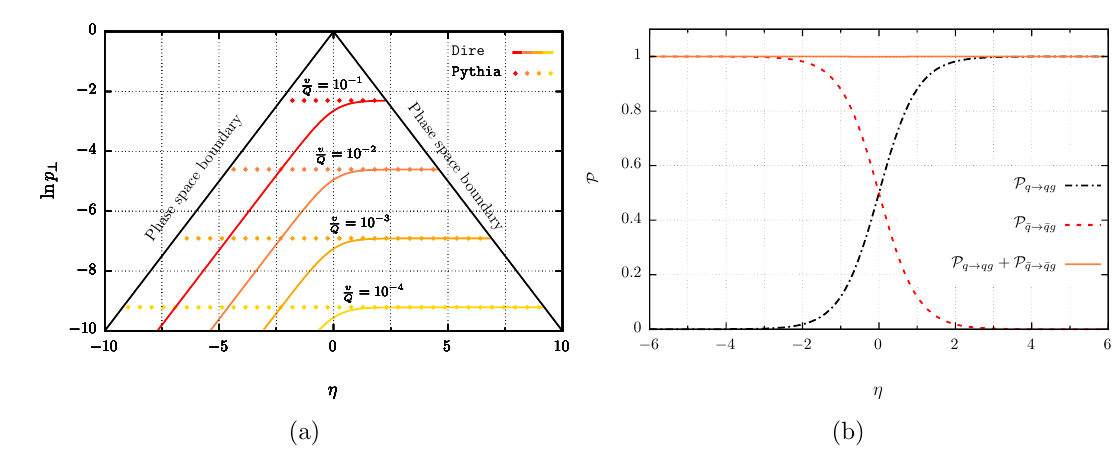
Figure 1. (a) The accessible contour of emissions in the (cid:17) (cid:0) ln p ? (\Lund" [78]) plane for (cid:12)xed values of the ordering variable v , for splittings of a right-going quark, shown for both the Pythia and Dire shower kernels. The phase-space boundary is sometimes alternatively described as the hard- collinear limit. (b) The splitting weights associated with emissions as a function of rapidity from the (right-going) quark and (left-going) anti-quark, normalised so as to be 1 in the soft-collinear region. This holds for both Pythia and Dire . The weights are independent of v , as long as v=Q (cid:28) e (cid:0)j (cid:17) j , i.e. as long as one is far from the phase-space boundary shown in (a). The rapidity is de(cid:12)ned in the q (cid:22) q dipole centre-of-mass